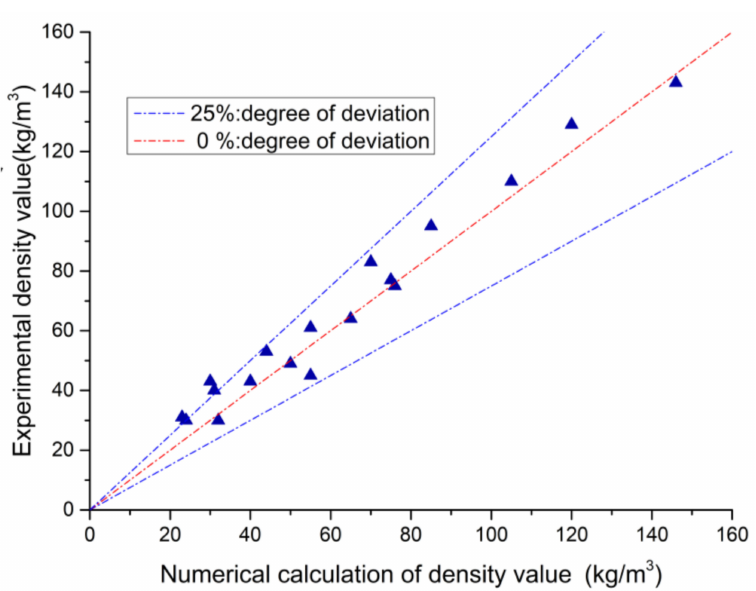
Figure 4. Frost density validation results.